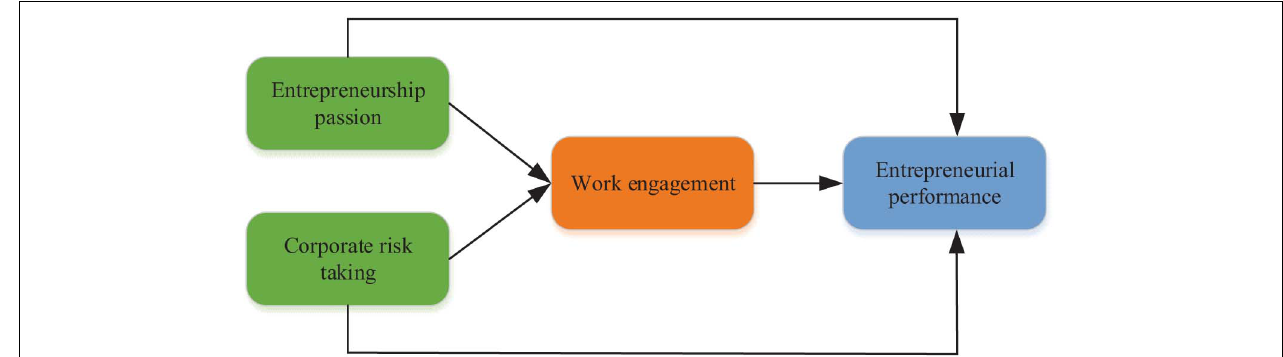
FIGURE 1 | Diagram of relationship structure of key